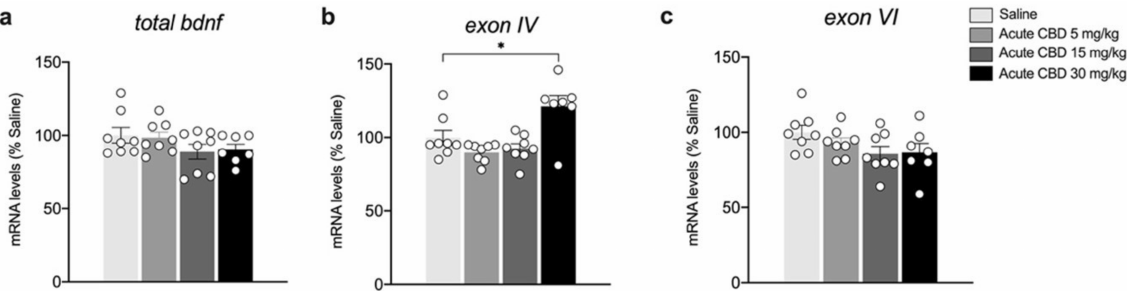
Figure 3. Effects of acute CBD exposure on Bdnf gene expression levels in the mPFC. Rats were treated with a single injection of CBD 5 mg/kg, 15 mg/kg, or 30 mg/kg, and killed one hour after the treatment. Total Bdnf ( a ), Bdnf exon IV ( b ), and Bdnf exon VI ( c ) mRNA levels in mPFC are expressed as percentages of saline-treated rats. Bar graphs represent the mean ± SEM from eight by Tukey’s multiple comparisons test, or Kruskal − Wallis one-way ANOVA for ranks followed by Dunn’s multiple comparisons test for non-normally distributed data. * p < 0.01 vs. saline-treated rats.